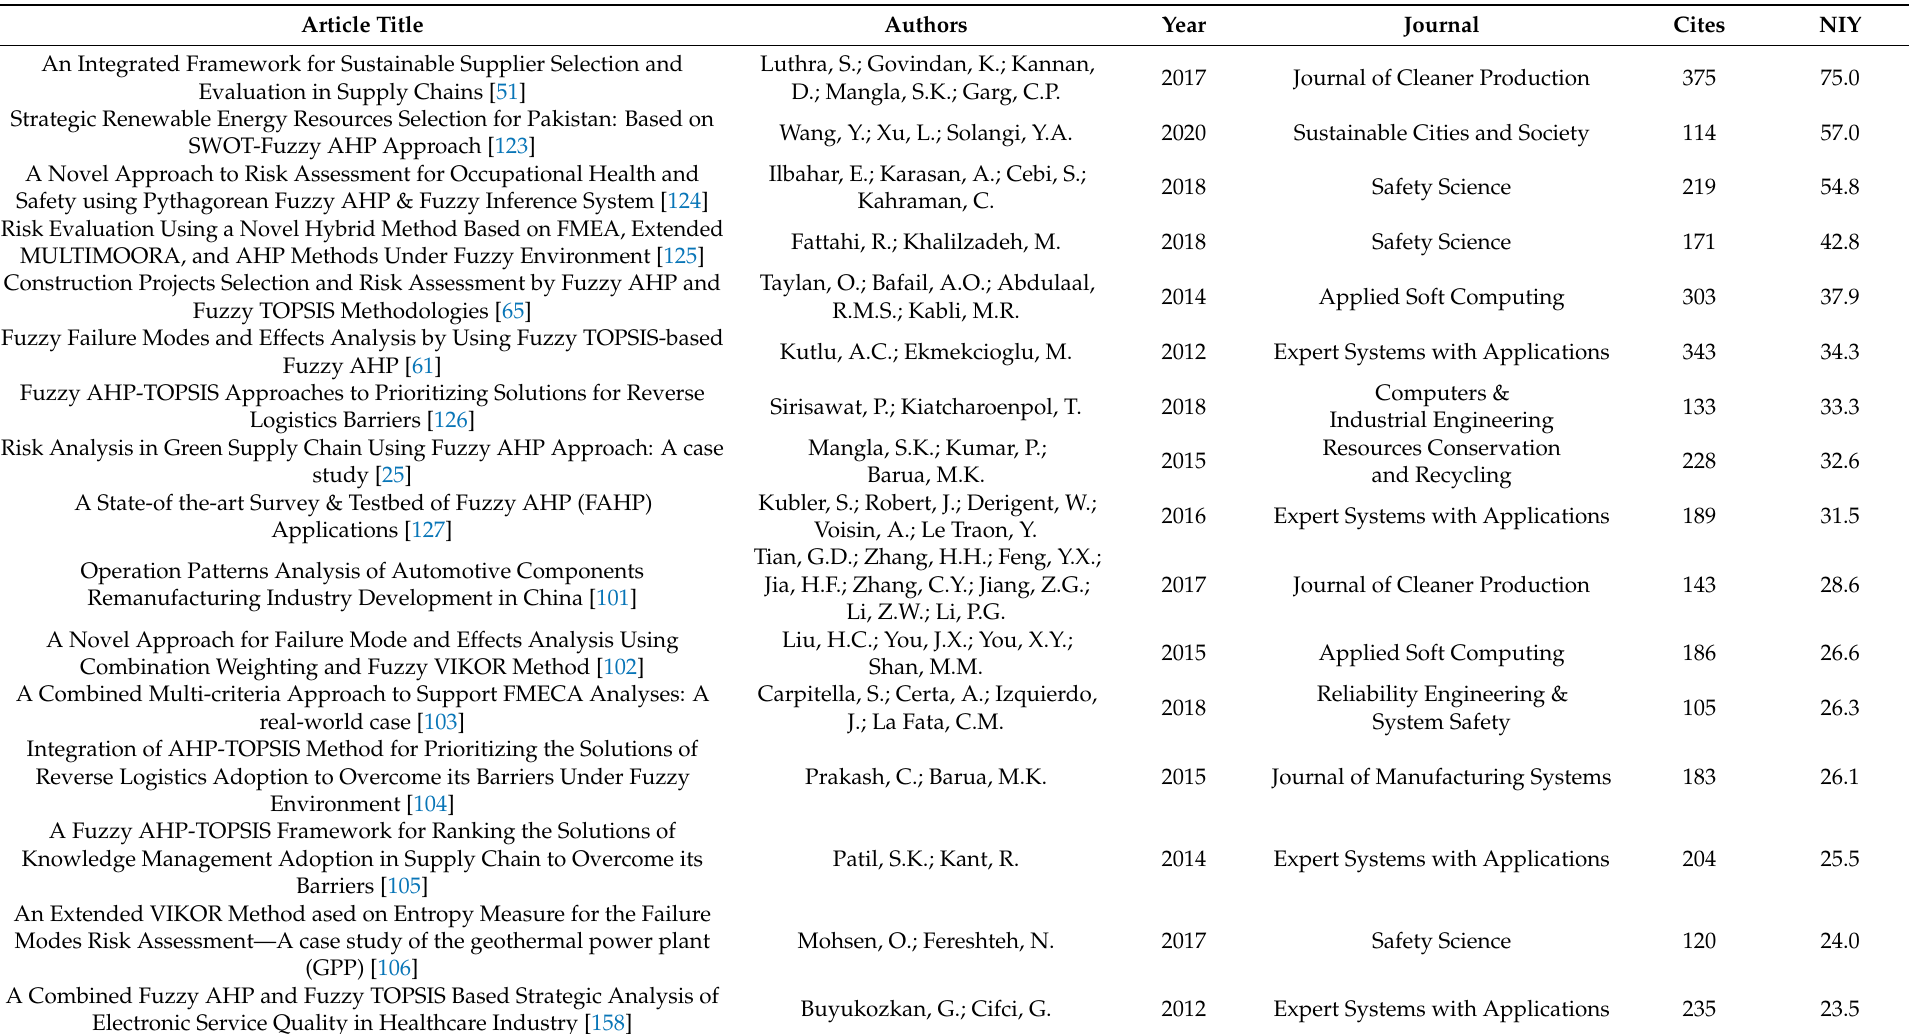
Table A2. Articles included in Cluster 2 sorted by